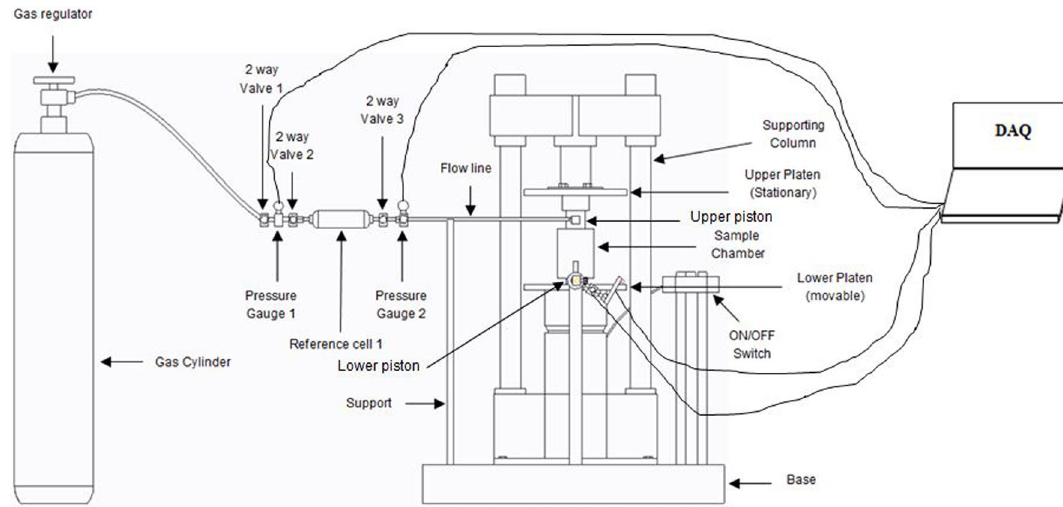
Fig. 3 Schematic diagram of gas permeability